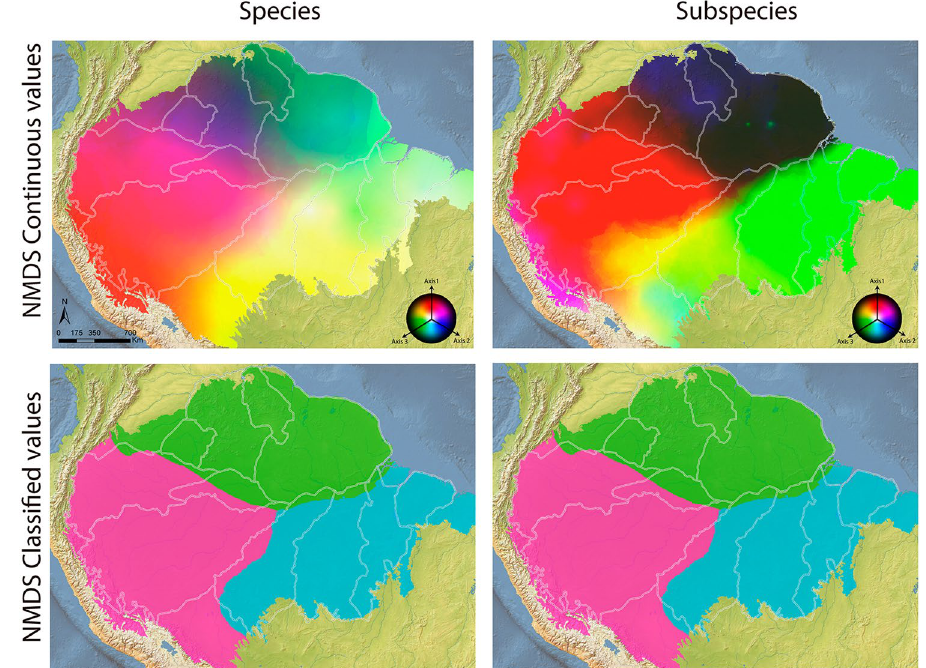
Figure 3. Spatial variation in bird species composition throughout the Amazon. Species composition were obtained by the interpolation of NMDS scores (three axis represented by a RGB scale) and the first three breaks (most significant in search order) in species composition identified by the Maximum Likelihood classification, both based on species and subspecies datasets. Maps created in ArcGIS 10 . 1